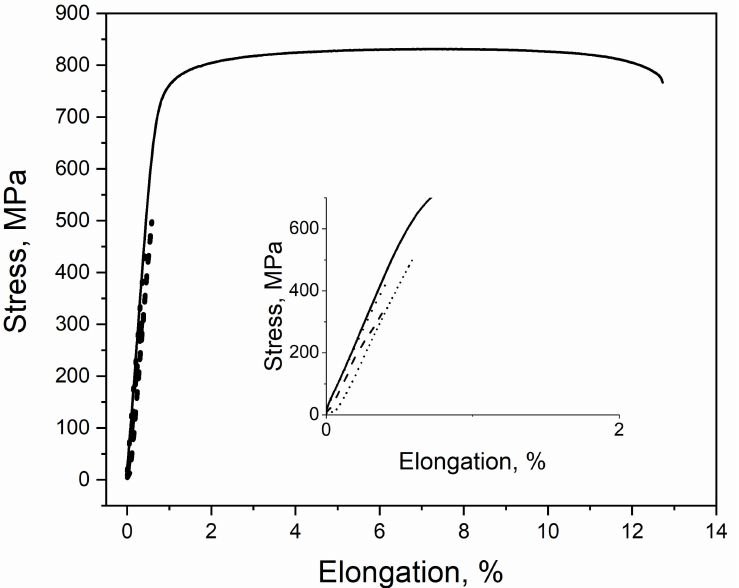
Figure 7. Results of tensile tests for initial Ti64 (solid line) and Ti64 sintered with Mg alloy (three sam- ples) after Mg degradation (broken lines). Insert shows the elastic region of measurements. Mea- surements of initial Ti64 were repeated three times which showed the similar behavior in elastic and plastic regions. One curve is presented to keep the figure clear.